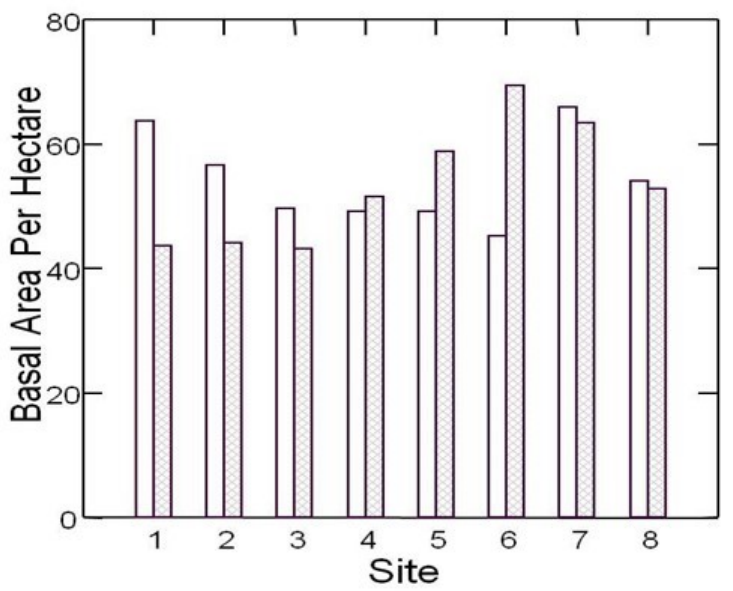
Figure 2. Basal area for stations A (open) and B (hatched) at sites 1–8 in 2017.